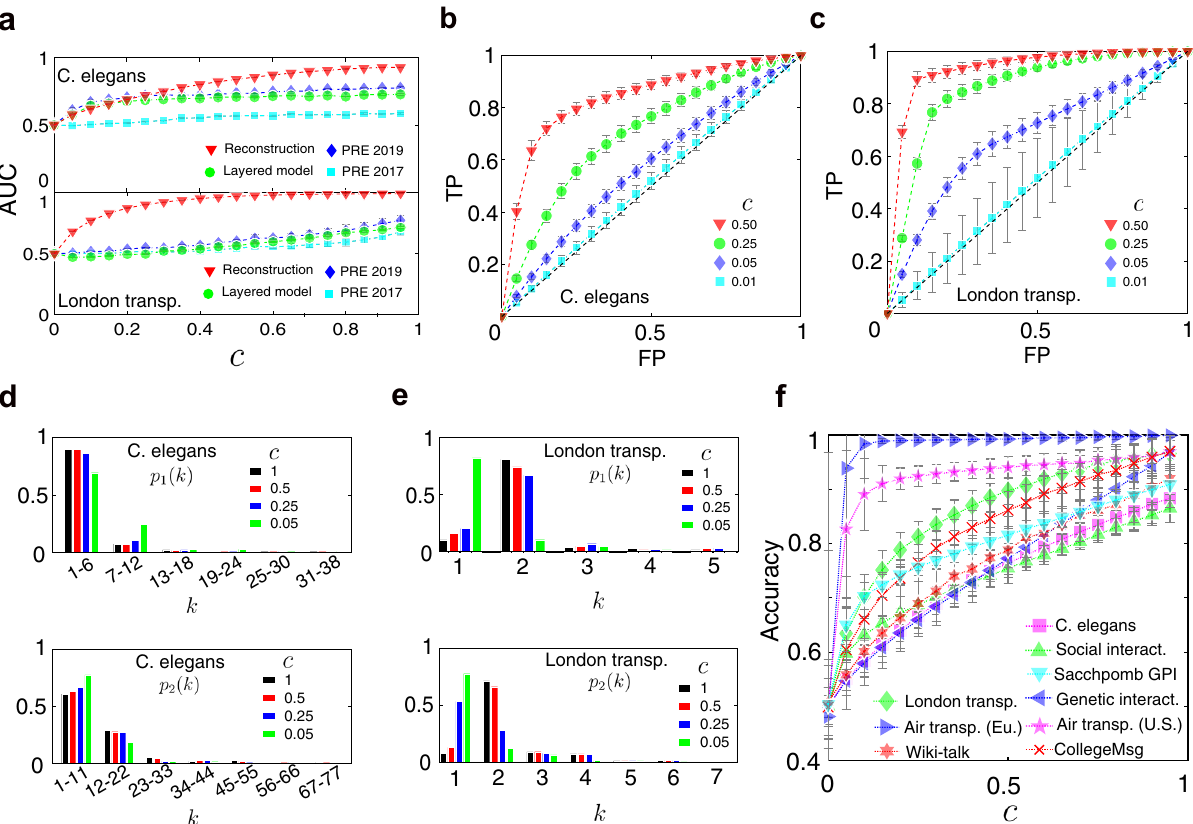
Fig. 3 Performance of our reconstruction framework in various real multiplex networks. We calculate the AUCs (area under the receiver operating characteristic curve) by four methods for C. elegans neural network and London transportation network in a , where the baselines refer to PRE 2019 41 , PRE 2017 40 , and Layered model (by a single-layer link prediction method, layer by layer, in the multiplex network). The ROC (receiver operating characteristic) curves for four speci fi c values of the fraction of partial observations c = 0.01, 0.05, 0.25, 0.5 are shown in b and c , respectively. Here the x -axis denotes the false positive rate and the y -axis denotes the true positive rate. Increasing the threshold results in fewer false positives (and more false negatives), corresponding to moving left on the curve from the top right corners to the left bottom along the ROC curve, where a random guess gives a point along the dashed diagonal line. The inferred degree distributions for three values of c are shown in d and e for the two real-world networks and compared to real ones ( c = 1). The x -axis indicates the degree k and the y -axis represents the probability that the degree of a randomly chosen node is equal to k . Further, for a speci fi c value of q = 0.5, we compare the accuracy of the reconstructed networks using our proposed framework for nine real-world networks in f by increasing c from 0 to 0.95. The error bar indicates the standard deviation in this fi